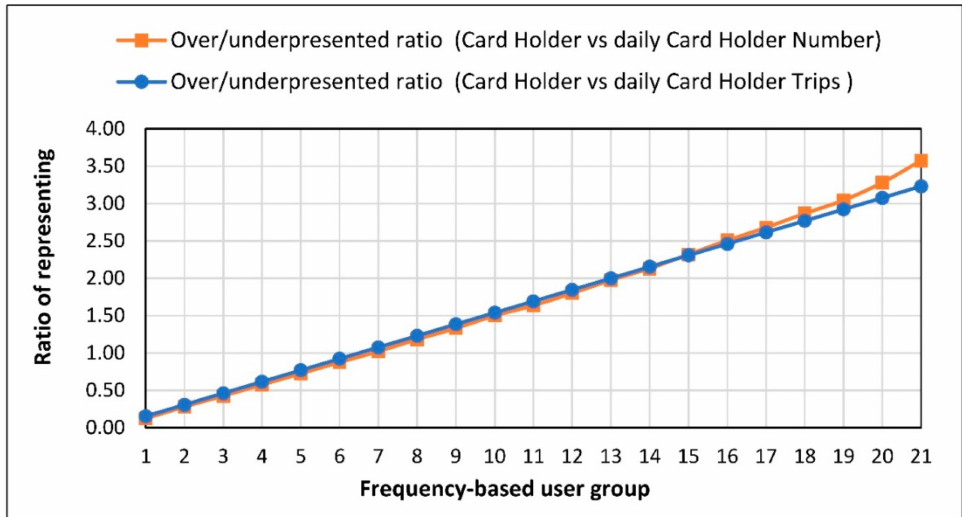
Figure 6. Raito of workday share to 1 month share of each frequency